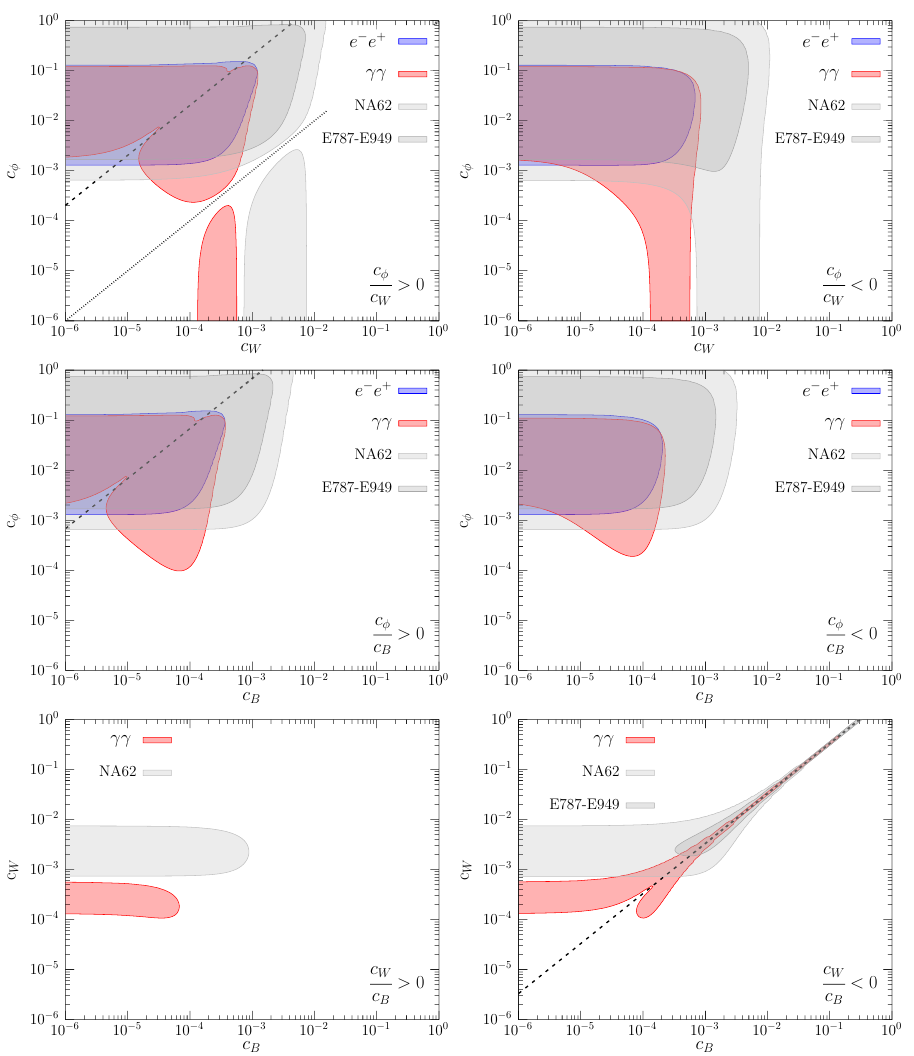
Figure 4 . MicroBooNE sensitivity projections, assuming two couplings are non-zero at a time. The shaded colored regions satisfy ∆ χ 2 > 5 . 99 (corresponding to the sensitivity at 95% CL for 2 d.o.f.) from a search for a γγ (red) or e + e − (blue) signal. Results are shown for f = 1 TeV a and m = 200 MeV , for N = 2 . 2 × 10 21 , and assuming σ = σ = 20% . Left (right) panels a PoT s b are obtained assuming a positive (negative) relative sign between the operators introduced. The diagonal lines indicate destructive interference between different operators entering the production rate (dotted lines) or decay width (dashed lines), see text for details. In all panels, the shaded gray regions indicate the portions of parameter space disfavored by NA62 [21, 40] (light gray), and E787 & E949 [20] (dark